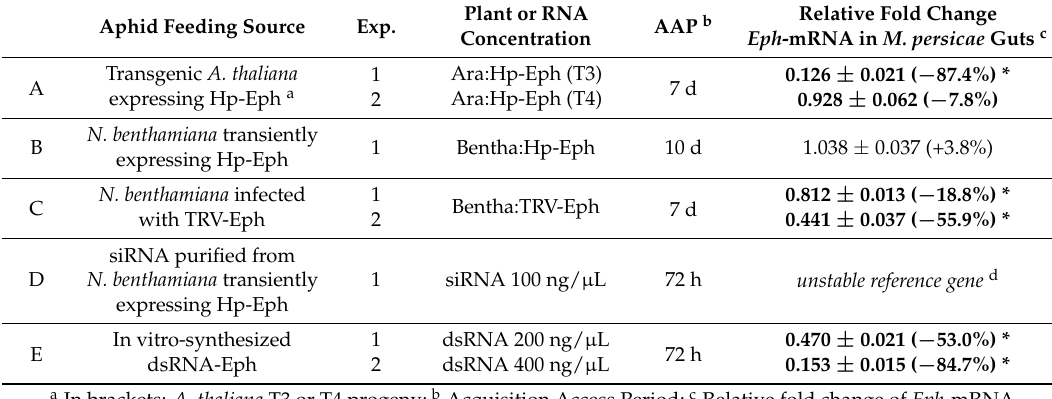
Table 2. Silencing efficiency of Eph in M. persicae guts using different RNAi-based methods. Aphid Feeding Source Exp.